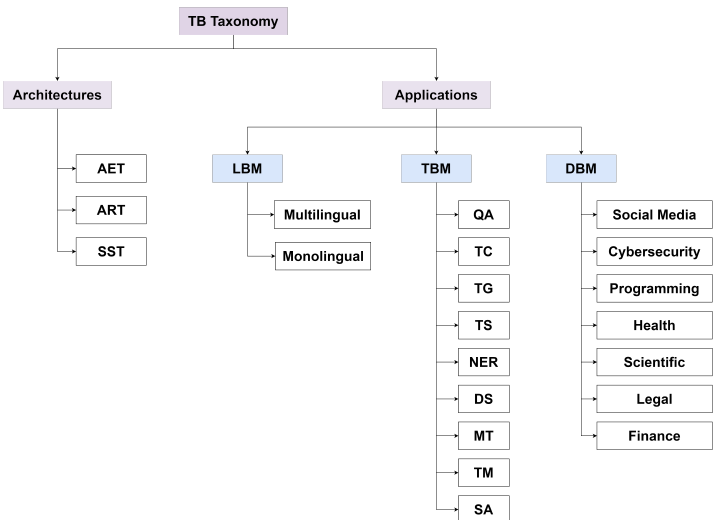
Figure 6. Reviewed TB models’ proposed taxonomy. It separates them into models based on architectures and models based on applications. We defined three aspects of the applications: domain-based models’ applications (DBM), downstream-based models’ applications (TBM), and language-based models’ applications (LBM).